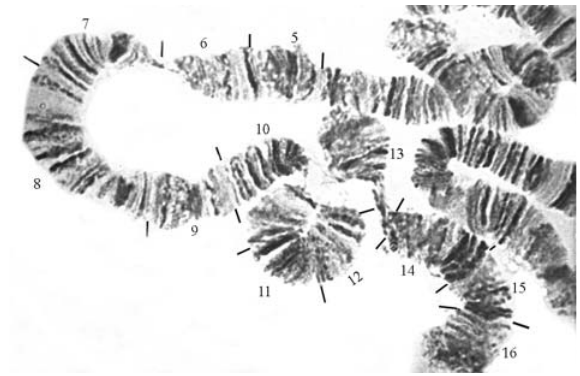
Figure 6 - Photomicrograph of the X chromosome of Drosophila aragua, in which the ectopic pairing of regions 10 through 13 can be observed.